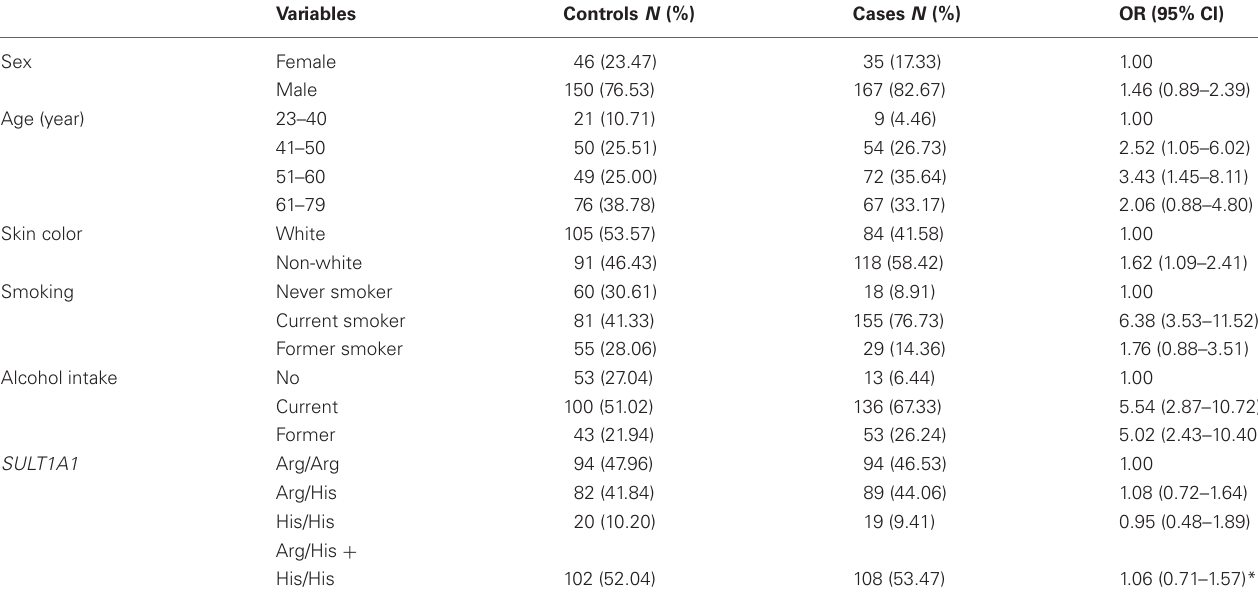
Table 1 | Distribution of oral cancer cases and controls according to sex, age, skin color, smoking, alcohol intake, and Arg 213 His SULT1A1 genotype, Rio de Janeiro, Brazil, 1999–2002.